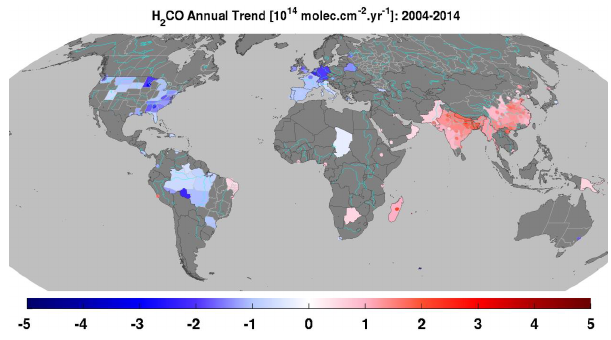
Figure 17. Annual absolute trends observed in the OMI H 2 CO columns between November 2004 and August 2014. The change in the OMI spatial sampling over the years has been taken into account in this trend